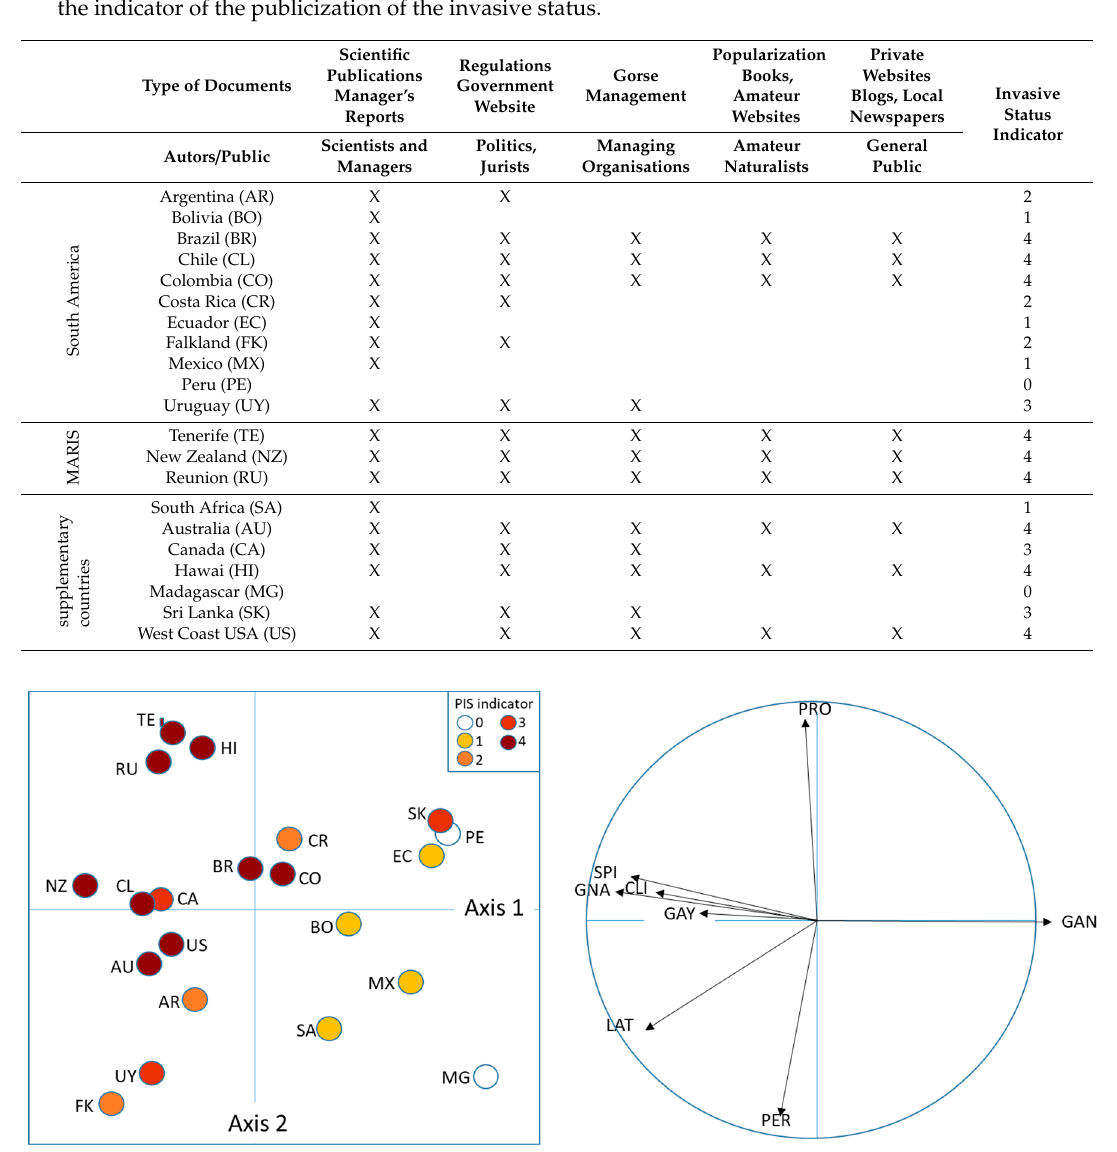
Figure 1. Results of Hill and Smith Analysis on the Publicization of Invasive Status (PIS) indicator. (Left) : distributions of the countries studied on the first two axis. ( Right ): projection of the explanatory variables on the first two axis. Country abbreviations are given in Table 3, variables abbreviations are given in Methods, Section 2.2. Table 4. Absolute contribution of the first three axis and relative contribution (%) of each variable to these axis. In bold, contribution > 15%.